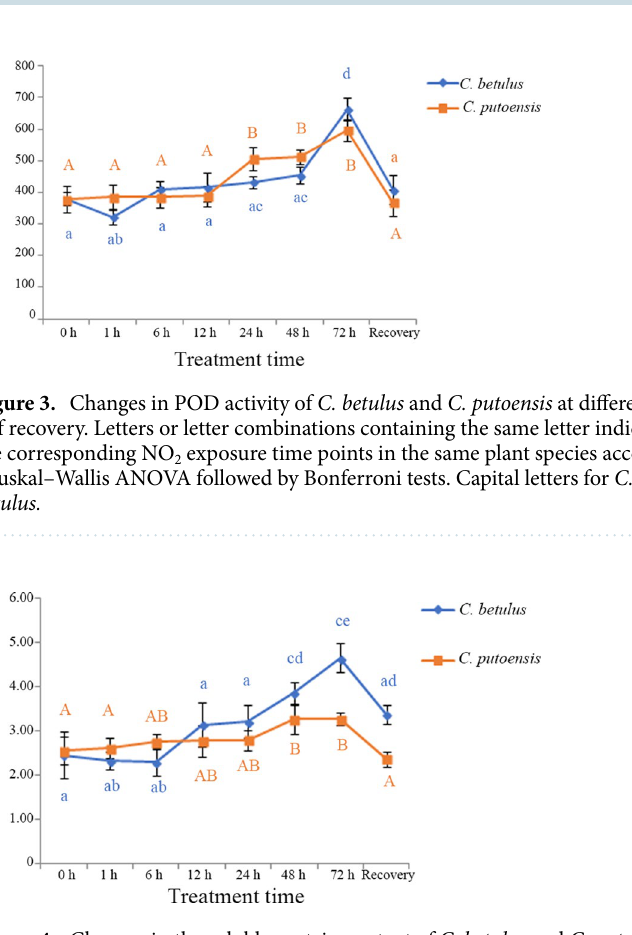
Figure 4. Changes in the soluble protein content of C. betulus and C. putoensis under NO 2 stress at different time points and after self recovery. Letters or letter combinations containing the same letter indicate no significant difference between the corresponding NO 2 exposure time points in the same plant species according to ANOVA or nonparametric Kruskal–Wallis ANOVA followed by Bonferroni tests. Capital letters for C. putoensis and lower letters for C.